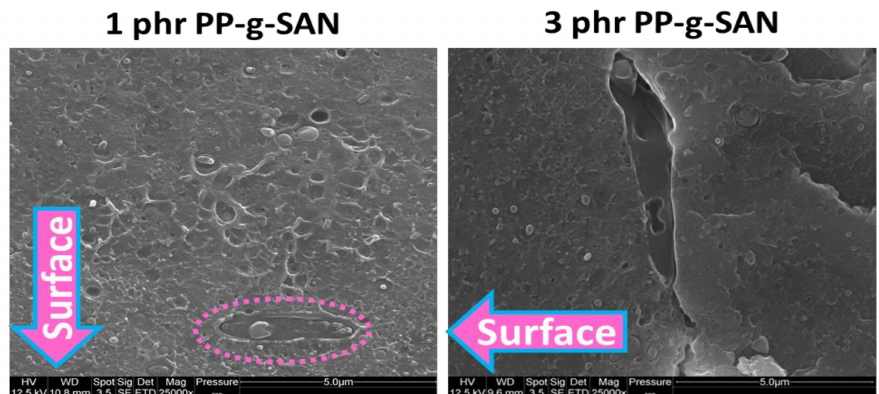
Figure 13. SEM pictures of cryofractured dogbones of ABS contaminated with 4 wt% PP and added with PP-g-SAN at 1 and 3 phr—25,000 × magnifications—pictures taken within 100 µ m from the surface—arrows indicates surface direction—supposedly PP-g-SAN phase.